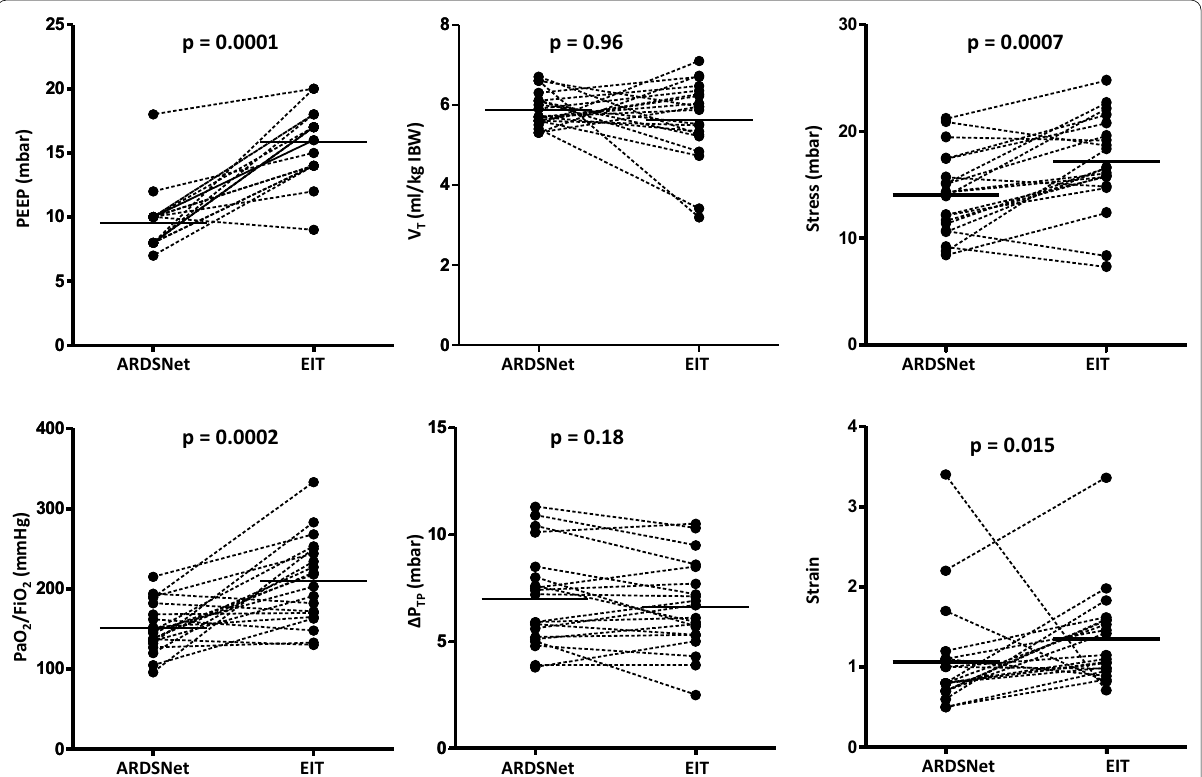
Fig. 2 Changes in positive end-expiratory pressure (PEEP), tidal volume ( V T ), elastance-based end-inspiratory transpulmonary pressure (Stress), ratio of arterial partial pressure of oxygen to inspired fraction of oxygen (PaO 2 /FiO 2 ), transpulmonary driving pressure (Δ P TP ) and strain after individualization of ventilator settings according to the electrical impedance tomography (EIT) protocol. ARDSNet acute respiratory distress syndrome network recommendations with low PEEP/FiO 2 table; EIT to EIT-based